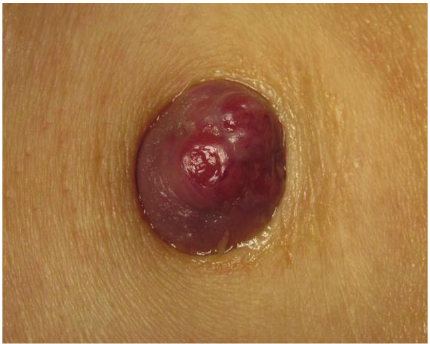
Figure 1: A 2cm firm, protuberant, ulcerated tumor was observed in the umbilicus.